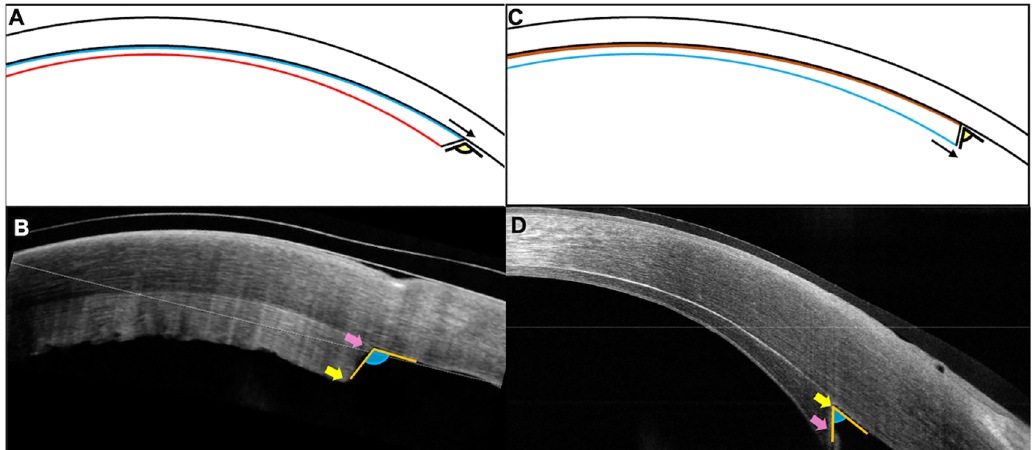
Figure 2. (A, B) Schematic image and the corresponding clinical picture of the inverted lenticule showing the longerendothelialside(blueline,pinkarrow)towardsthehoststromawhichhastheirregulardonorstromal surface (red line, yellow arrow) facing the anterior chamber. The graft is forming an obtuse angle with the host cornea. (C, D) Graft attached in its correct orientation with the endothelial side facing the anterior chamber with its edge extending beyond the edge of the stromal surface (black and pink arrows). The compact graft has an acute angle at the edge interface with the host stroma.